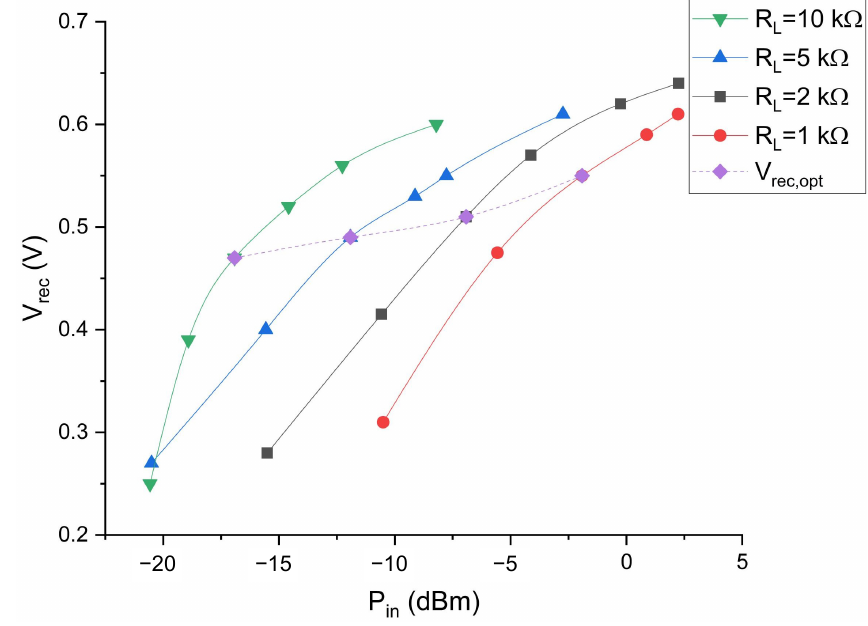
Figure 12. Output voltage of cross coupled rectifier with different load